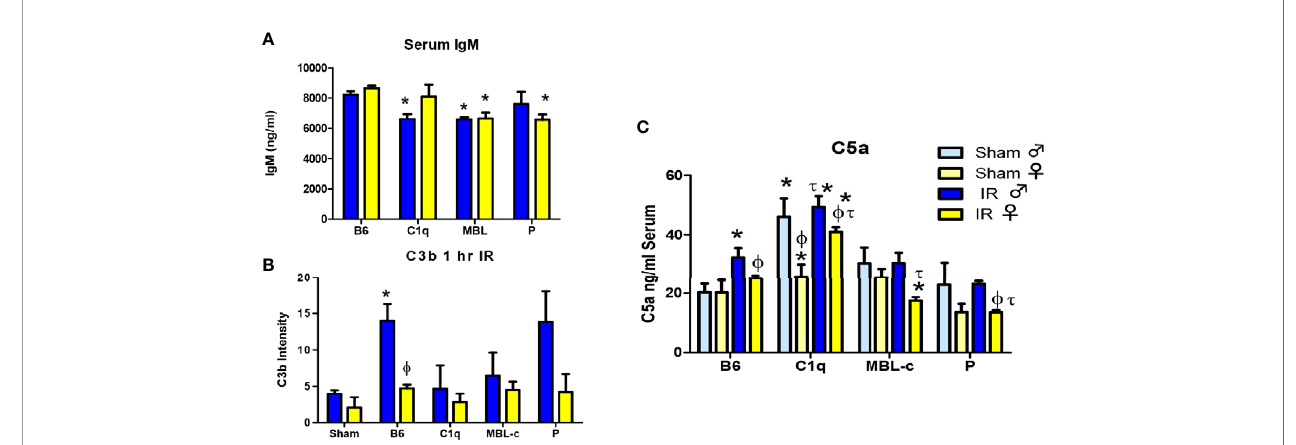
FIGURE 5 | MBL-C or Factor P de fi ciency decreases serum IgM, C3b and C5a levels in both sexes following intestinal IR. (A) Serum from untreated C57B6L/J WT, C1q - / - , MBL - / - , and P - / - male (blue) and female (yellow) mice was analyzed by ELISA for IgM. Sham treatment is indicated by light colors whereas IR is indicated by dark colors. Each bar represents 2-3 pools of 3-5 mice. (B) C3b deposition on intestines from male (blue) and female (yellow) C57B6L/J WT, C1q - / - , MBL - / - , and P - / - mice was examined after Sham and IR treatment with 120 min reperfusion. Each bar represents 3-4 animals in at least 3 independent experiments (C) Serum C5a from C57B6L/J WT, C1q - / - , MBL - / - , and P - / - mice was determined after Sham and IR treatment with 120 min reperfusion. Sham treatment represents pooled analysis of all strains. Each bar is representative of 7-12 mice per group. Serum IgM and C5a were measured with sandwich ELISA. C3b deposition was quantitated by Image J analysis after IHC. * indicates signi fi cant difference between IR treatment and Sham within the same sex (P ≤ 0.05), as determined by 1-way ANOVA with Newman Keuls post-hoc test; Ф indicates signi fi cant difference between sexes in the same time point same treatment (P ≤ 0.05), as determined by unpaired t-test; t indicates signi fi cant difference between same sex IR compared to WT IR (P ≤ 0.05), as determined by 1-way ANOVA with Newman Keuls post-hoc